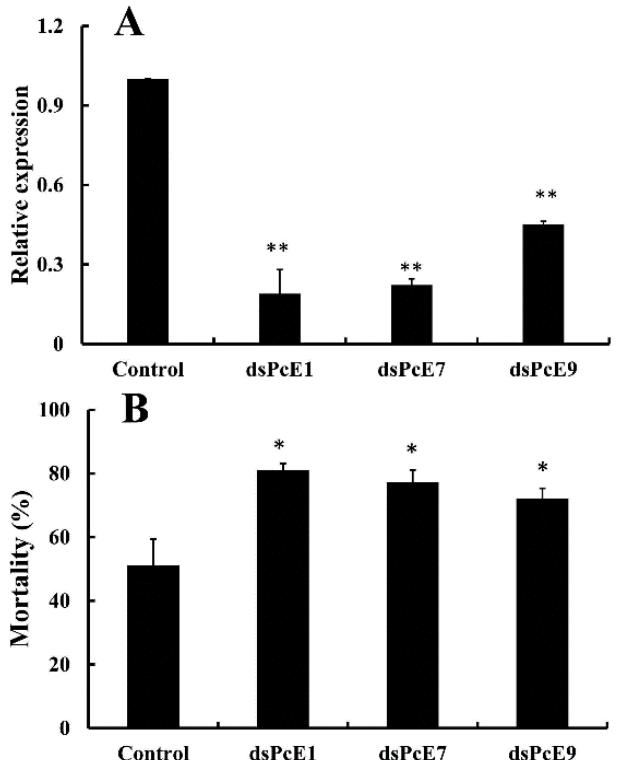
Figure 5. Susceptibility of Panonychus citri to fenpropathrin after silencing of PcE1, PcE7 and PcE9 by RNA interference. ( A ) Silencing efficiency of PcE1, PcE7 and PcE9 after P. citri were investigated 48 h after the gene silencing treatment; ( B ) The mortalities of the citrus red mites were investigated after the fenpropathrin treatment at the concentration of LC 50 (4.519 mg/L). Results were mean ± SE of four biological replication ( n = 4). The asterisk on the vertical bars indicate significant differences in the mRNA level of the three genes or the mortalities between control and treatment (Student’s t -test, * p < 0.05 and ** p < 0.01).